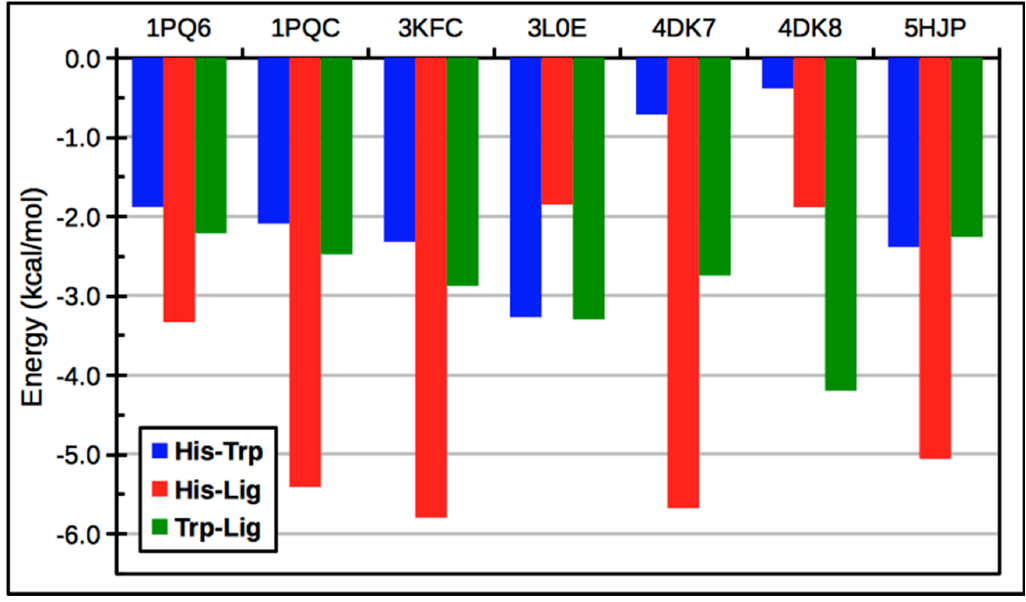
Figure 13. Calculated interaction energies for His435-Trp457, ligand-His435, and ligand-Trp457 interactions.